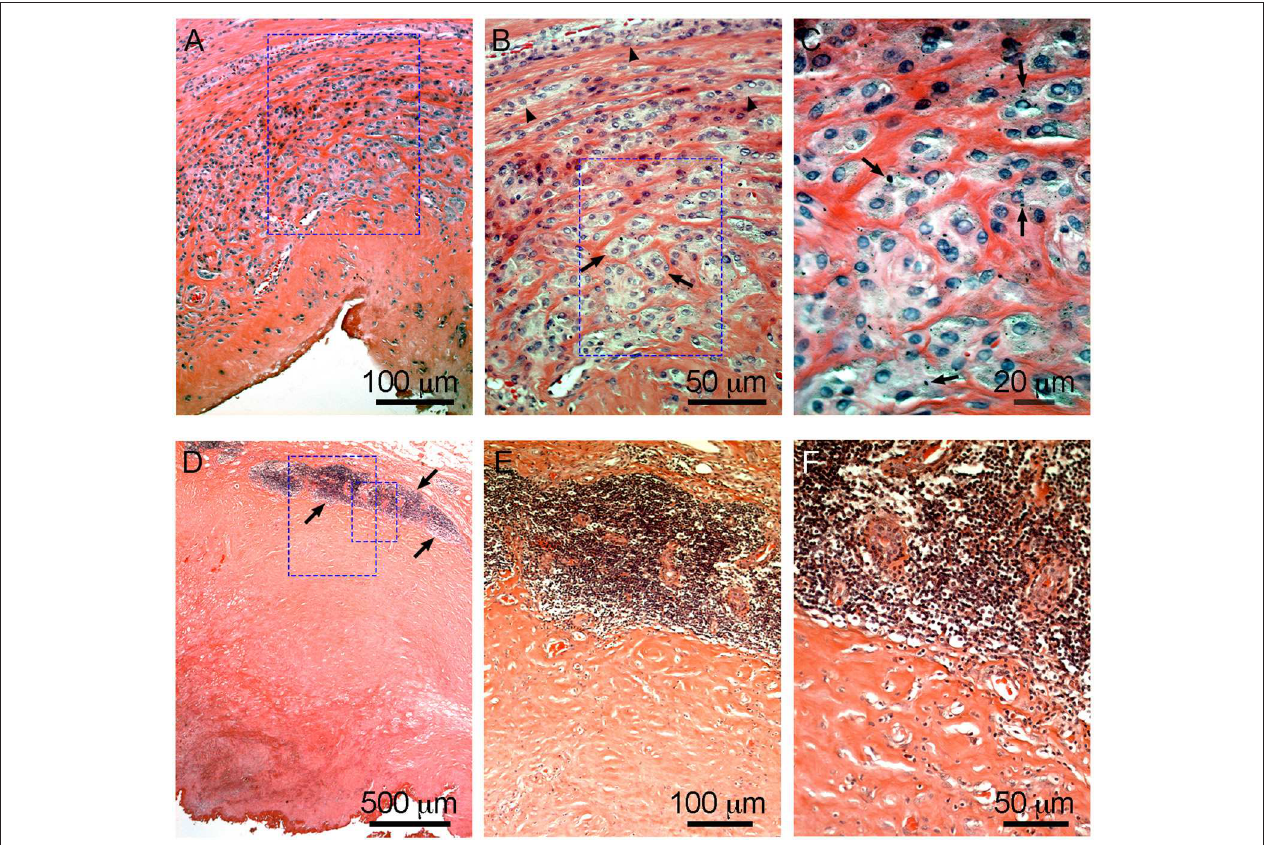
FIGURE 6 | Characteristic macrophage-dominated ALTR (A–C) and ALTR with lymphocyte infiltration and hypersensitivity features (D–F) . Macrophage dominated lesions are associated with evidence of high wear, corrosion, and elevated Co and Cr in serum (53 and 48 µ g/L, respectively, in the case shown). ALTRs with predominant lymphocyte infiltrate and hypersensitivity features usually are not associated with elevated wear or corrosion and may be present with lower Co and Cr in serum (6.2 µ g/L and 1.2 µ g/L in the case in D–F ). Low extension of sub superficial necrosis is observed in macrophage-dominated lesion with macrophages that infiltrate the whole synovium (A) , forming clusters (arrows) or epithelioid cells (arrowheads) in (B) , and multiple micron/sub-micron particles (arrows) are observed in macrophages cytoplasm (C) . Hypersensitivity feature ALTRs usually present with large extension of sub superficial necrosis (D) , with perivascular lymphocyte infiltration that form large aggregates (over 1mm) and may constitute tertiary lymphoid organs (arrows in D,E ), with low (or none) number of particles observed in the tissues (F)